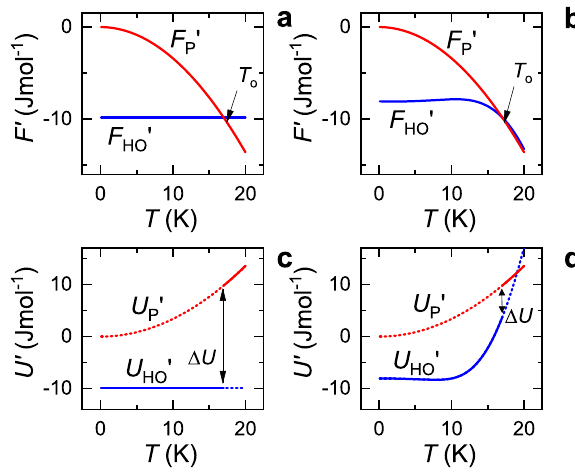
2 Si 2 at ¼ F 0 . b Free P HO